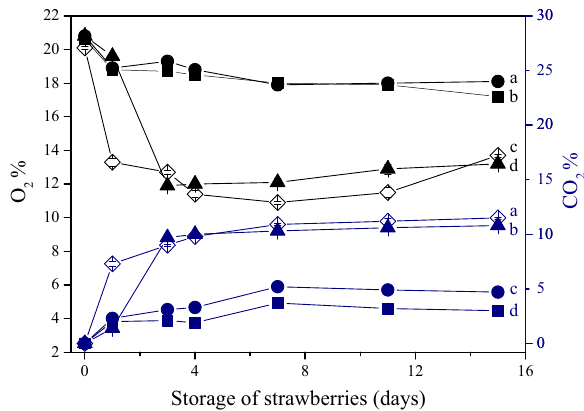
Figure 3. Respiration activity in terms of O 2 (black) and CO 2 (blue) during 15 days of isothermal storage of strawberries at 10 °C in containers sealed with conventional PVC (◊), SFMPI ( ▲ ), SFMPI-NCC ( ● ) and SFMPI-BNC ( ■ )-based films. Different letters for the same evaluation factor indicate statistically significant differences ( p <